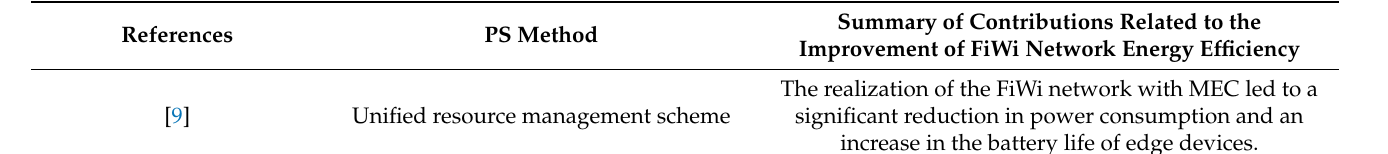
Table 4. Summary of the related works on PS methods in networks based on the MEC